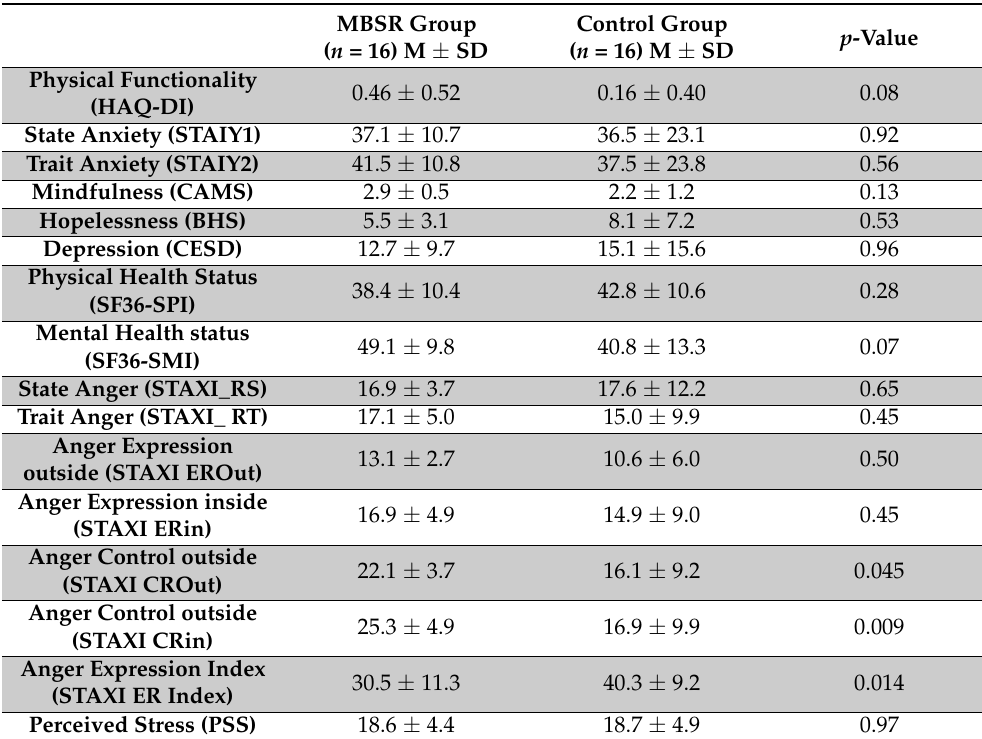
Table 2. Clinometric variables of the study participants in the MBSR program and differences between groups after 2